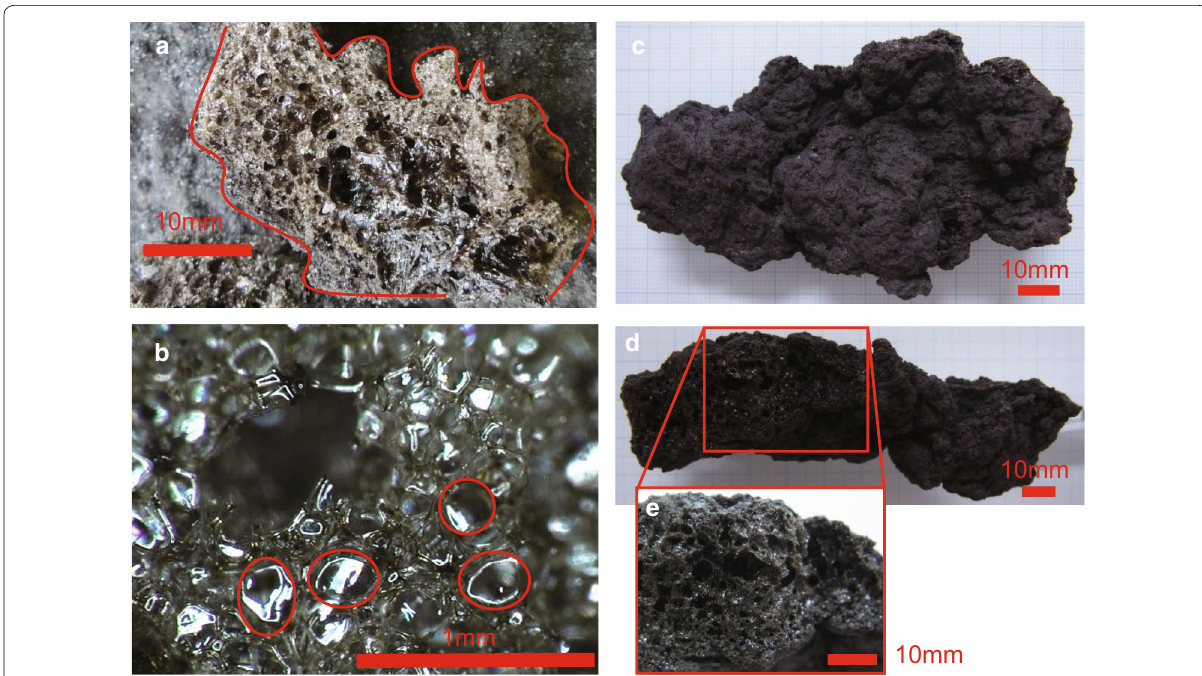
Fig. 2 Photographs of scoriae and their magnified views. a A high-porosity scoria found at the 3rd crater (Fig. 1c). The red curve outlines the scoria. b Magnified view of the high-porosity scoria. Red circles indicate the typical vesicle sizes. c – e A flattened scoria found at the western rim of the 1st crater observed from the top ( c ) and side ( d ), and the e broken-out section denoted by the red rectangle in ( d ). The aspect ratio (thickness/width) of this flattened scoria is